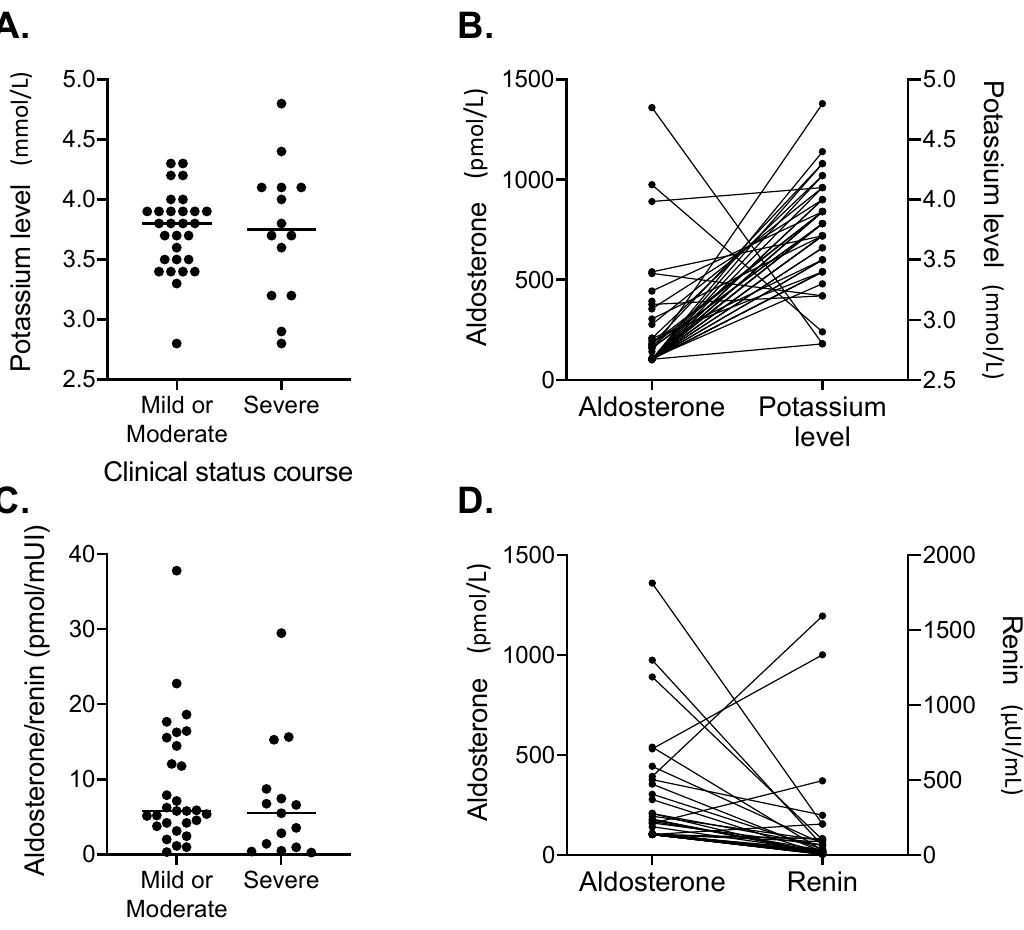
Figure 1. Laboratory findings of RAAS explorations. ( A ) Plasmatic aldosterone levels according to the maximal ordinal scale (OS) during the overall period of hospitalization classified in two groups: mild or moderate (OS max ≤ 4) and severe (OS max ≥ 5).; ( B ) Plasmatic aldosterone and potassium levels for each patient; ( C ) Plasmatic aldosterone / renin ratio according to the maximal ordinal scale (OS) during the overall period of hospitalization classified in two groups: mild or moderate (OS max ≤ 4) and severe (OS max ≥ 5).; ( D ) Aldosterone and renin levels for each patient.